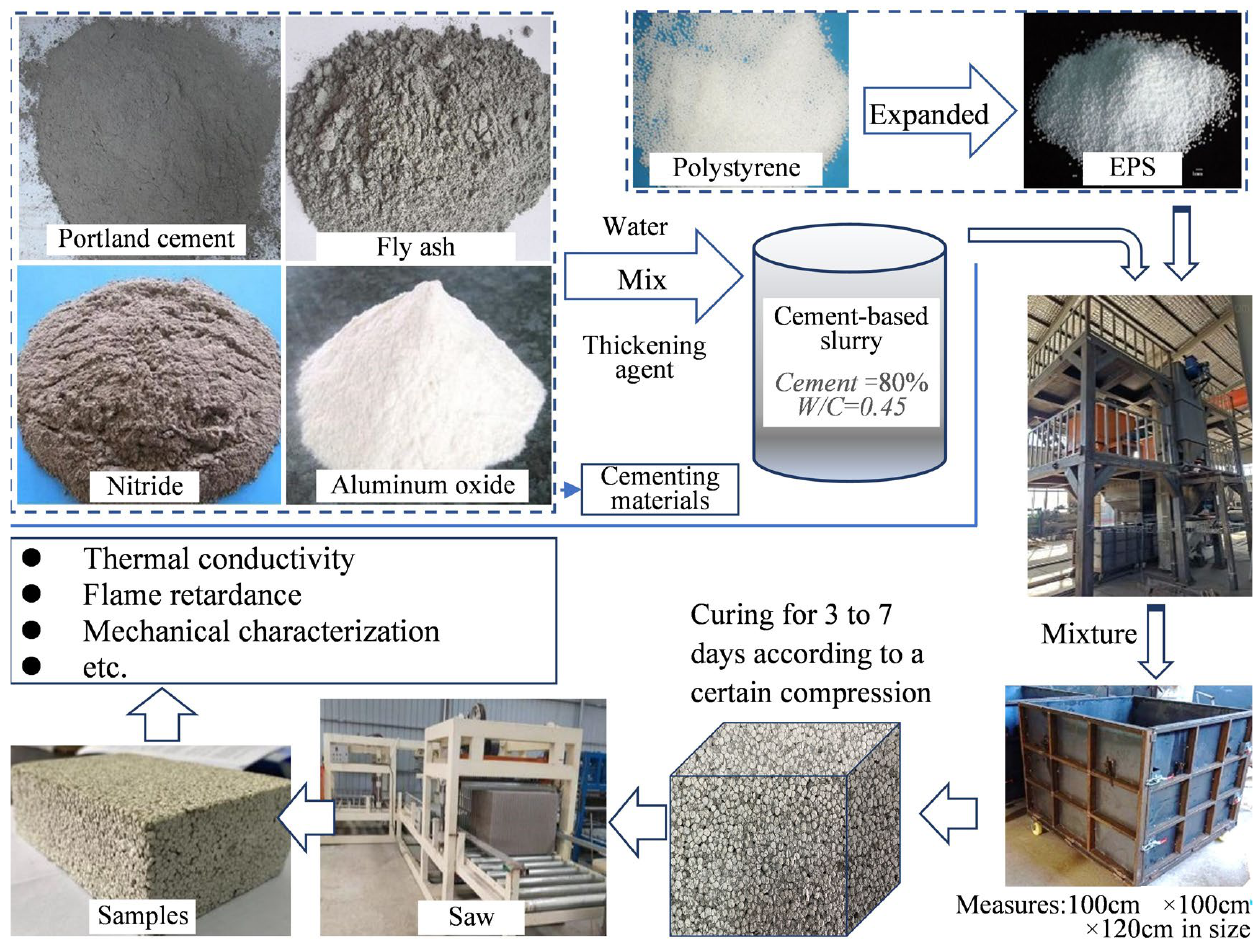
Figure 1. The preparation of CEPS specimen process and test flow diagram. Table 1. The description of the prepared CEPS mixture.